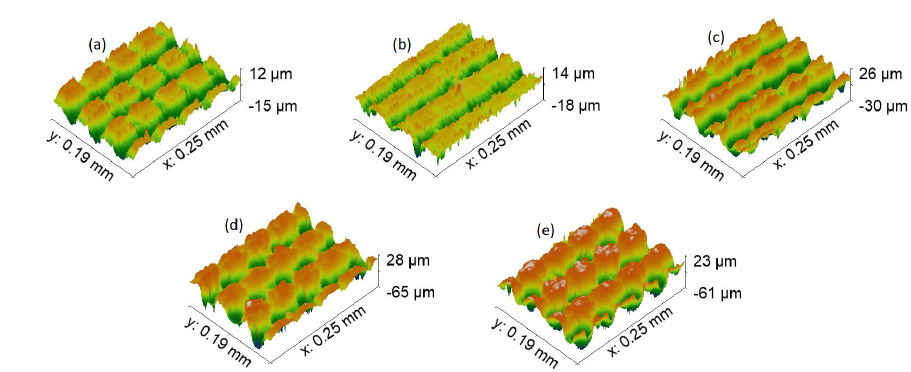
Figure 9. Topography, with × 50 magnification of each sample pillars texture. ( a )—17-4PH stain- less steel, ( b )—PH13 stainless steel, ( c )—Ti6Al4V titanium, ( d )—2024 T3 aluminum, and ( e )— 7050